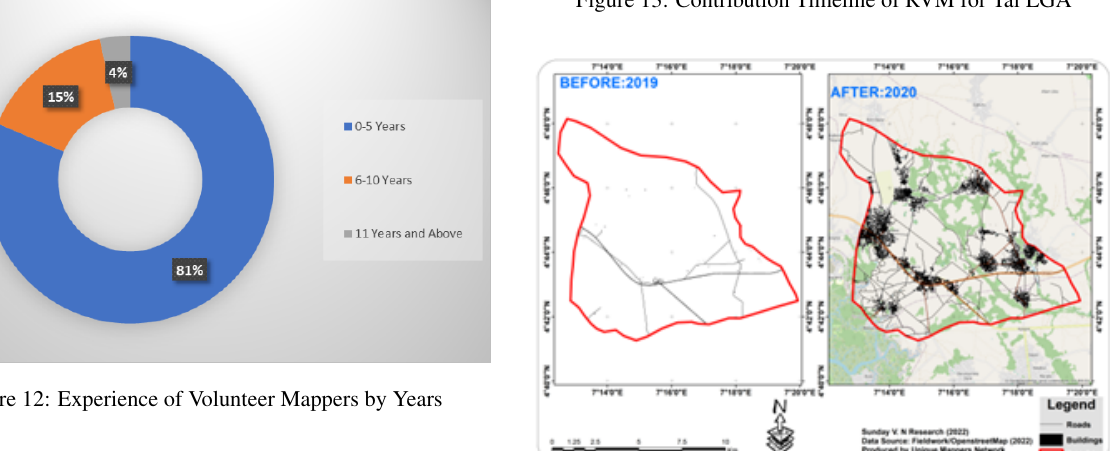
Figure 13: Contribution Timeline of RVM for Tai LGA